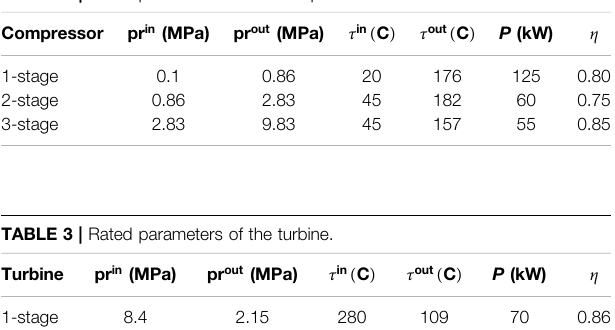
TABLE 2 | Rated parameters of the compressor.